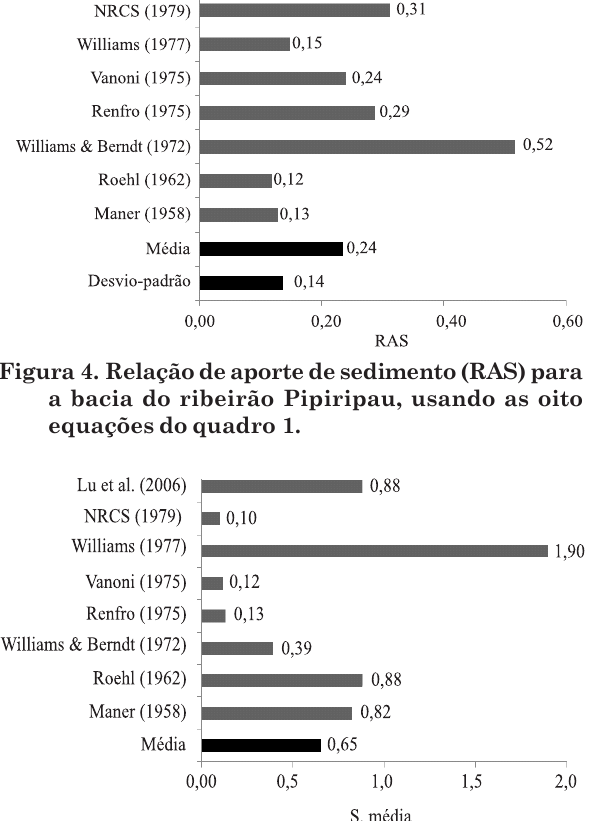
Figura 5. Sensibilidade relativa média das equações de RAS às suas